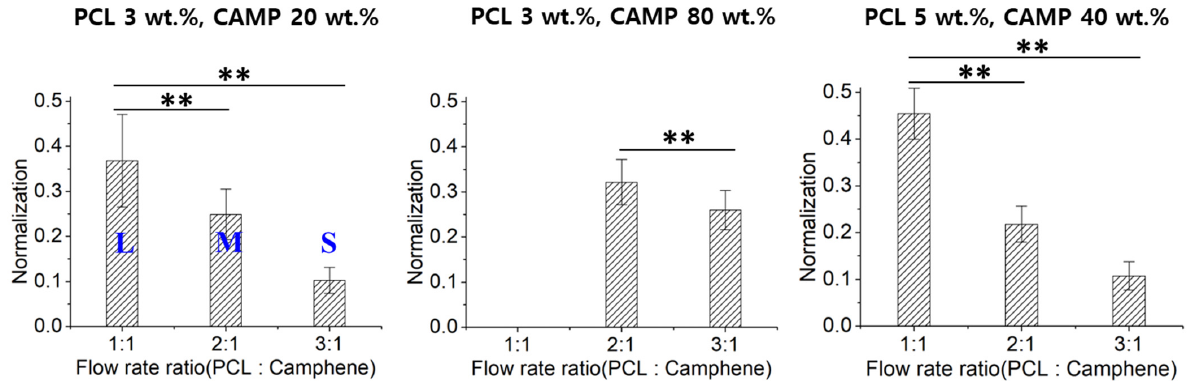
Figure 3. Normalized pore sizes of highly porous microspheres with respect to the flow rate ratios of PCL to CAMP (** p < 0.0001).